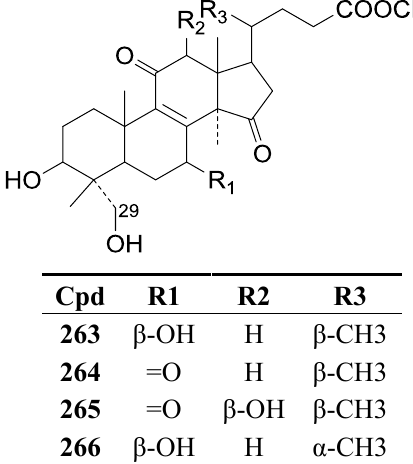
Figure 25. Structures of compounds 263 – 266 .